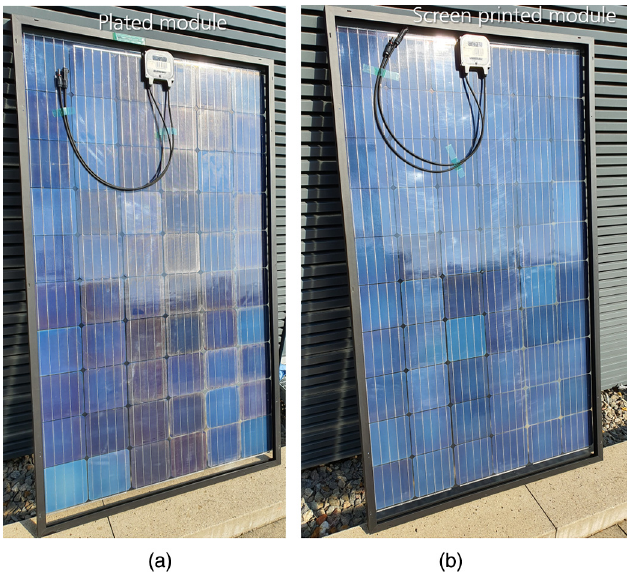
Fig. 4. Photograph of the rear side of a 60 cell module with bifacial TOPCon solar cells with either plated Ni/Cu/Ag metallization (a) or screen printed AgAl/Ag metallization